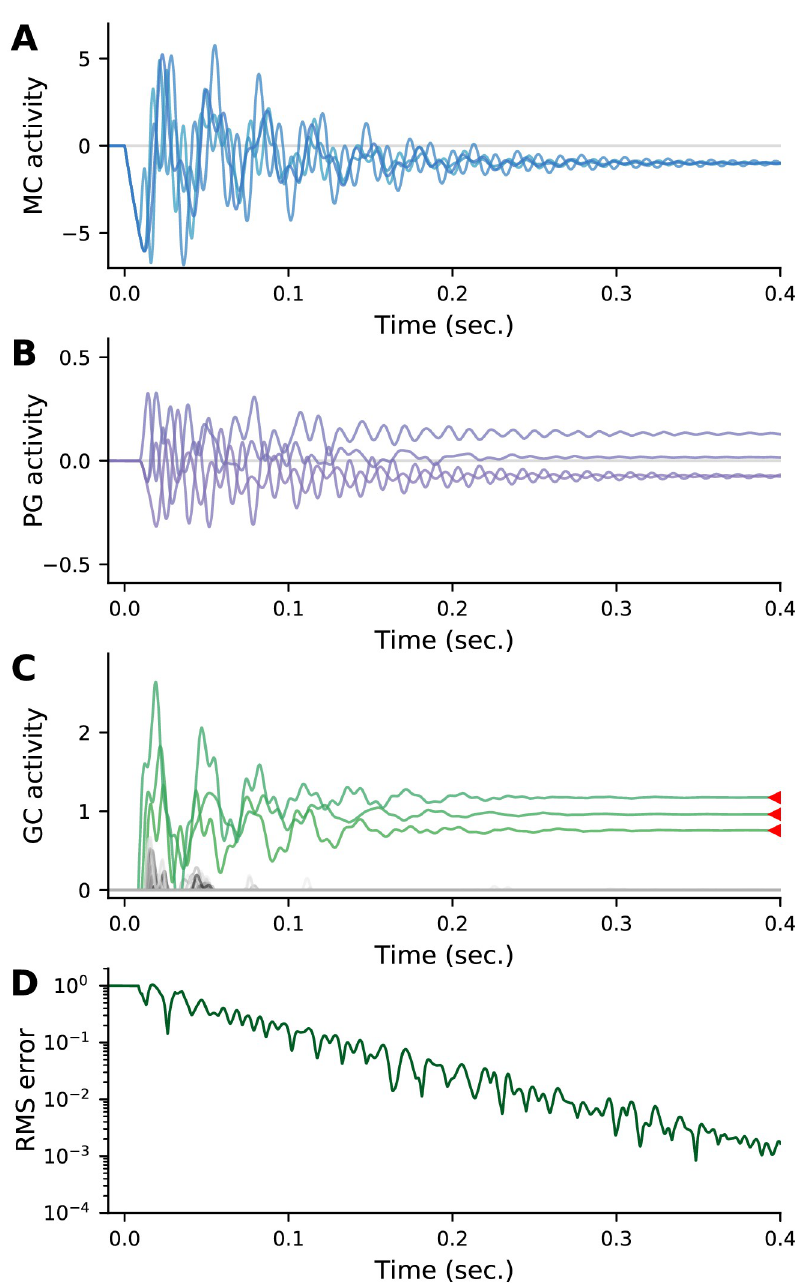
Fig 5. Example dynamics for a network with base parameters (Table 1). (A) All four sister mitral cells from a representative glomerulus. Although the sister cells start off with identical activations, their activities quickly diverge due to their differing connectivities to the granule cells. Ultimately, however, they converge to the same value. (B) Periglomerular cells from the glomerulus in panel A. (C) Granule cells. Red arrows indicate the MAP solution for the three components present in the odour. Granule cells representing these components are shown in green, the others in gray. After an initial period of activity, the system settles into the MAP solution. (D) Time course of the root-mean- square error between the granule cell activations and the MAP solution normalized to its initial value, indicating convergence to the MAP solution.